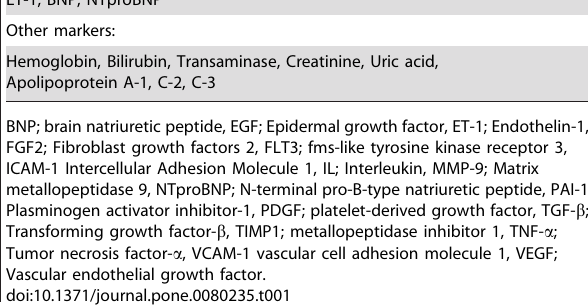
Molecule of cell proliferation and vascular remodeling Growth factors